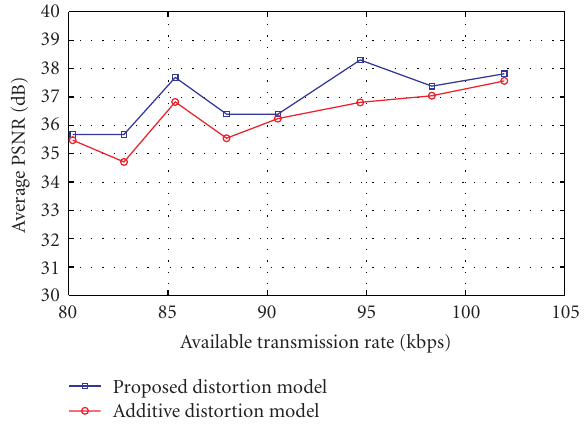
Figure 6: Average PSNR (in dB) as a function of available trans- mission rate (in kbps) for the “greedy-loss distribution” algorithm. Comparison between the proposed and the simplified “additive” distortion model for the video sequence News .